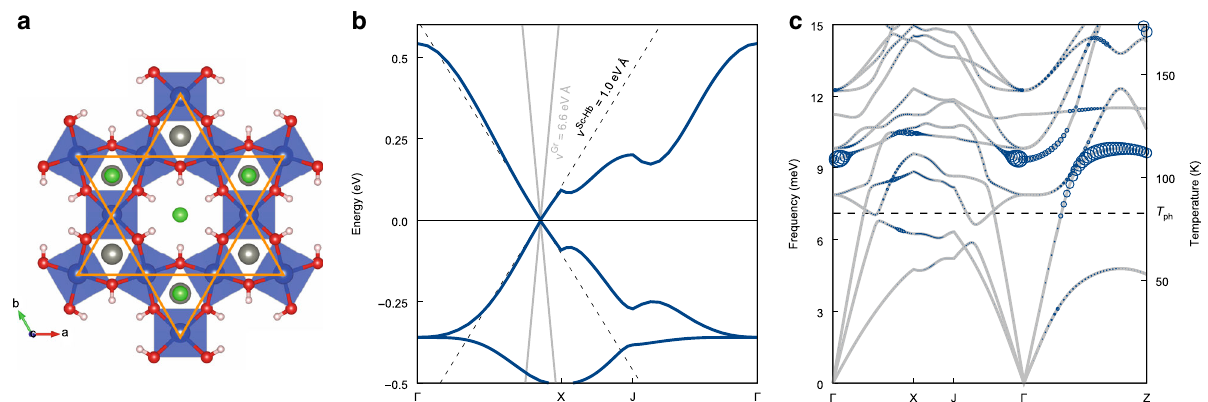
Fig. 2 First-principles analysis of Sc-Herbertsmithite. a Top view of the crystal structure, where the CuO 4 plaquettes form a Kagome lattice, as highlighted by the orange lines. b Ab-initio band structure of the low-energy manifold of Sc-Herbertsmithite along the high-symmetry directions of the conventional hexagonal Brillouin zone 21 . The dashed black lines refer to a linear fi t around the Dirac point of Sc-Herbertsmithite, whereas the solid gray lines denote the counterpart for graphene. c Phonon dispersion of Sc-Herbertsmithite (gray lines) and relative distribution of the electron-phonon coupling strengths λ ν q (blue circles, ν is the branch index, q the phonon momentum). The horizontal dashed line marks the temperature T ph above which optical phonon modes with sizeable λ ν q are thermally activated.